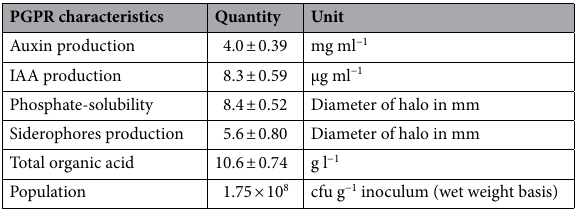
Figure 1 ns Figure 2 Figure 3 Figure 4 ns ns Figure 5